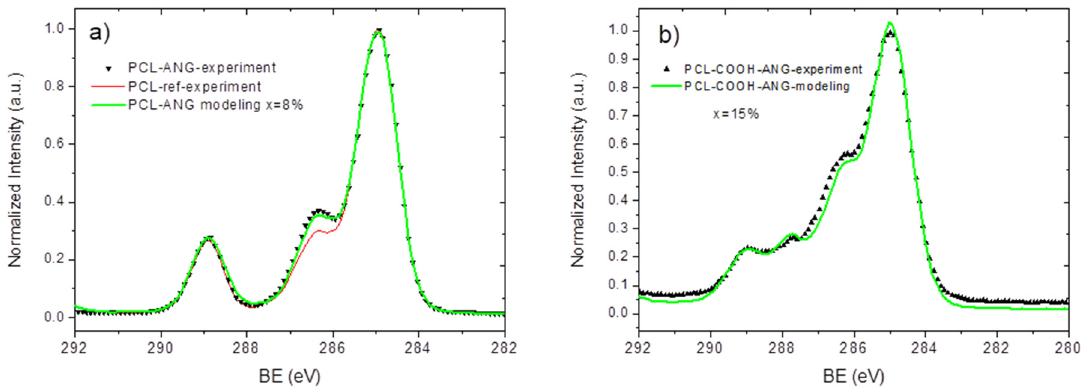
Figure 6. A comparison of the XPS C1s signals for PCL-COOH-Apo, which were measured experimentally and modeled with the different concentrations of protein (x) on the surface. An overview ( a ) and an enlarged image of the spectrum ( b ) are given to better show the effect of x on the similarity of the calculated spectrum to the experimental data.